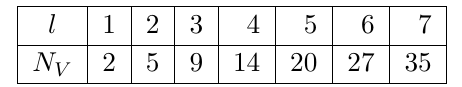
Table 3 . The number of propagators of the auxiliary graph at l